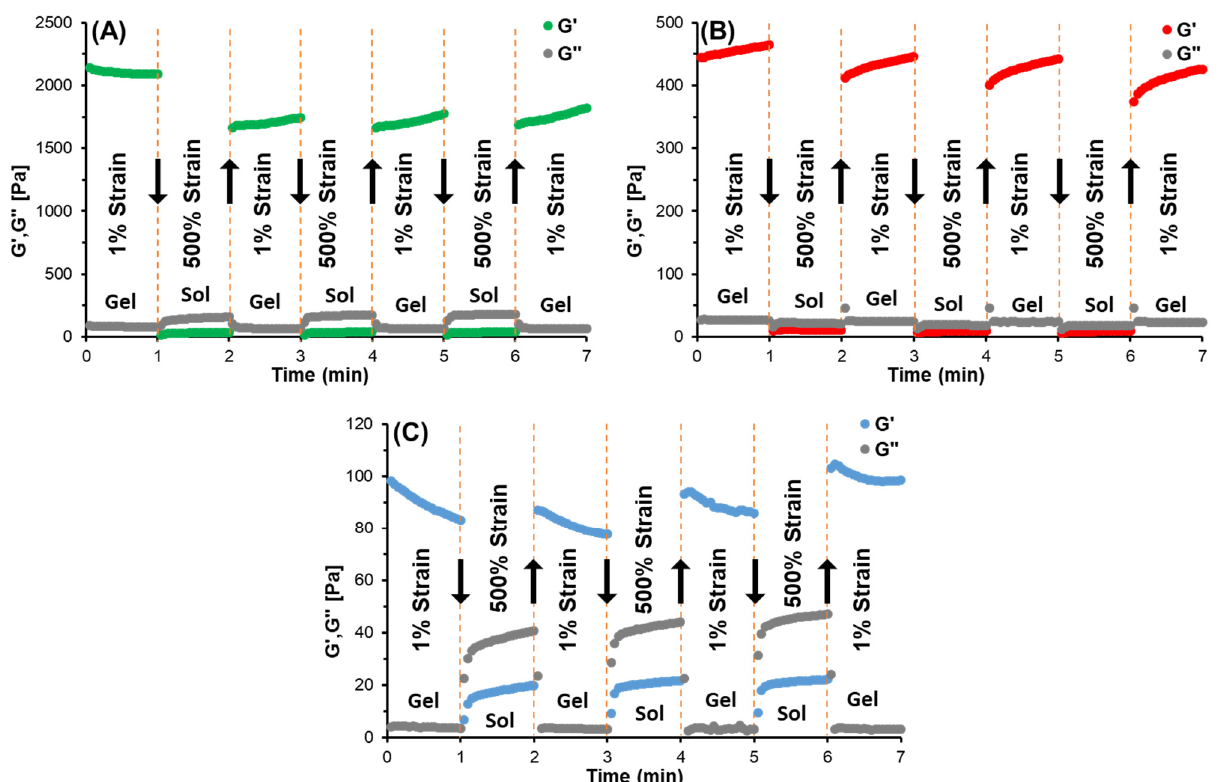
Figure 9. The self-healing and recovery of a PVA-CHO/CHIT-SH hydrogel after a high shear load through a continuous (1% strain → 500% strain → 1% strain) step strain method ( A ) 10% w / v PVA-CHO/CHIT-SH hydrogel, ( B ) 5% w / v PVA-CHO/CHIT-SH hydrogel, and ( C ) 2% w / v PVA-CHO/CHIT-SH hydrogel. The arrow indicates the change in the storage modulus (G ′ ). The injectable hydrogel was also intended to be used in tissue engineering [61,62].